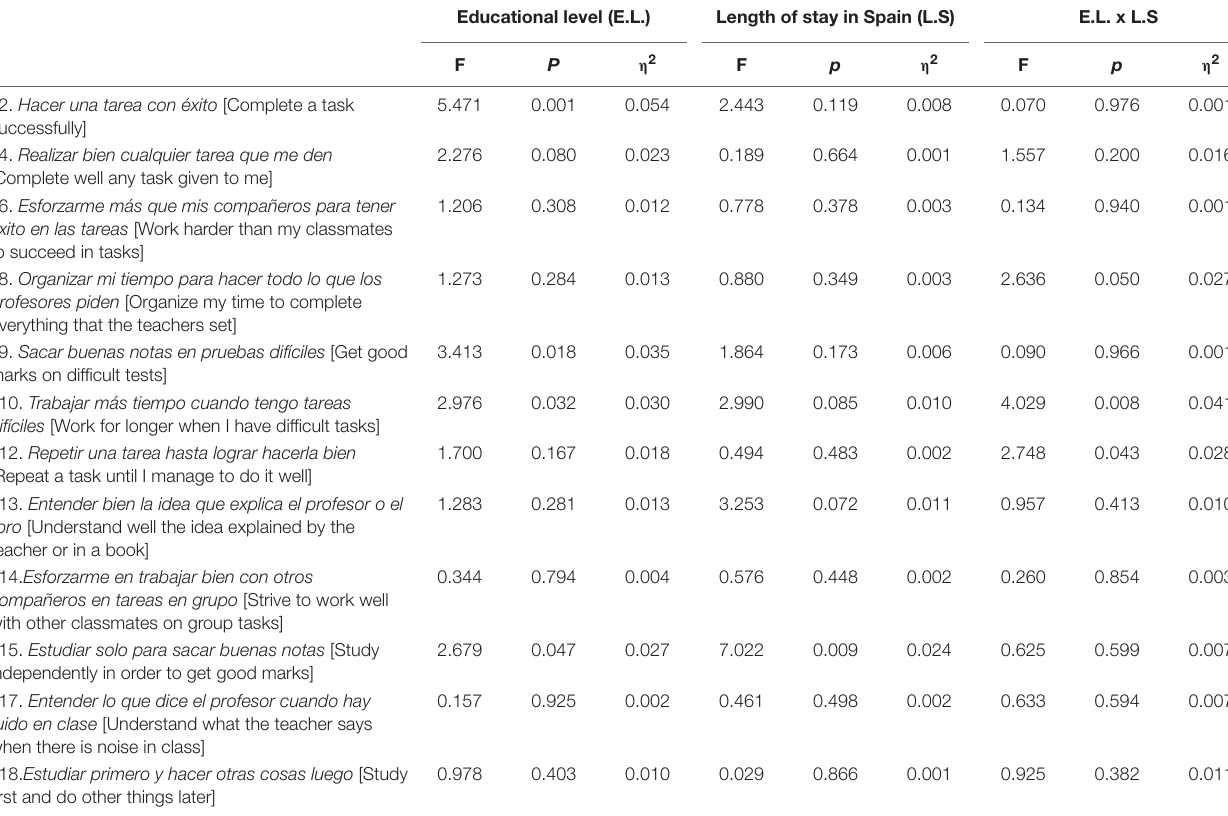
TABLE 2 | Multivariate ANOVA (MANOVA) results and effect sizes ( η 2 ) for academic self-efficacy, the length of time spent in Spain and educational level. Educational level (E.L.) Length of stay in Spain